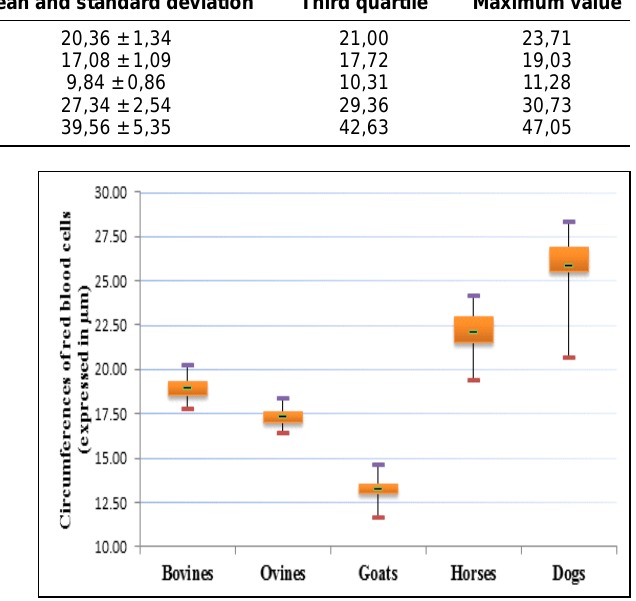
Figure-1. Influence of red blood cells diameter on the determinism of the species of pets.